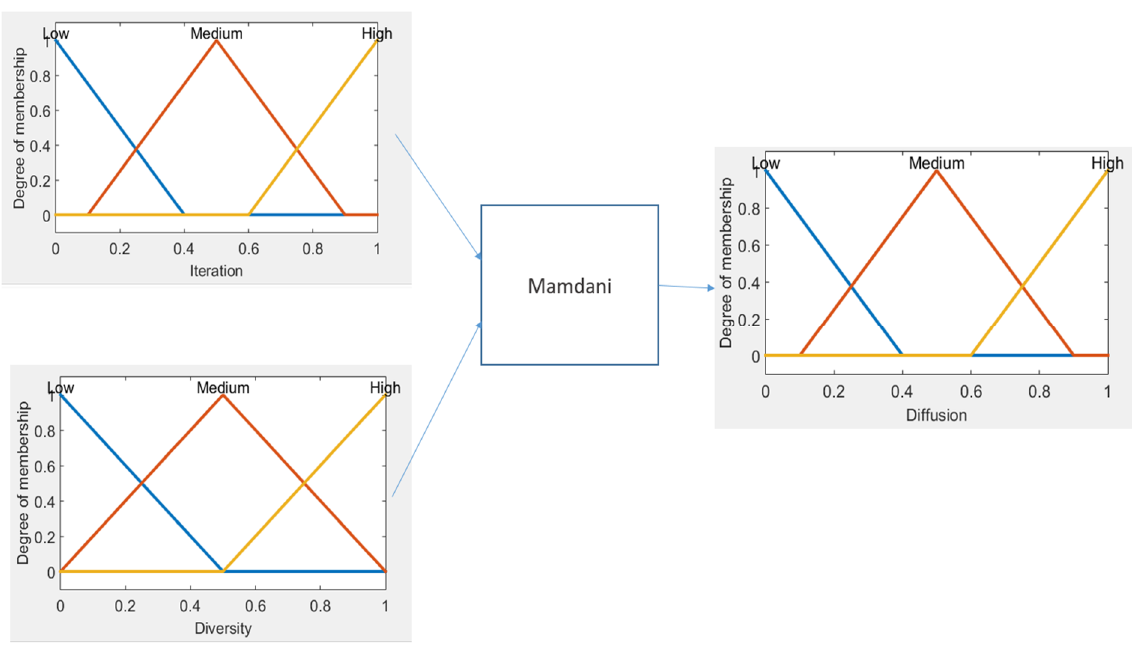
Figure 1. Type-1 fuzzy system for controlling diffusion .